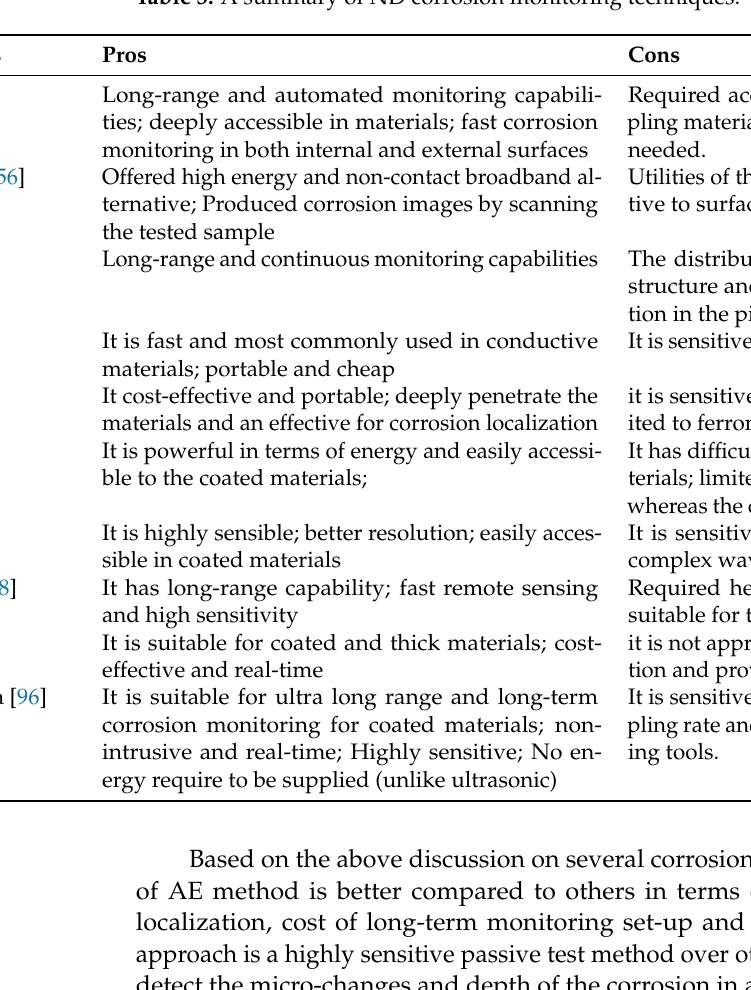
Table 3. A summary of ND corrosion monitoring